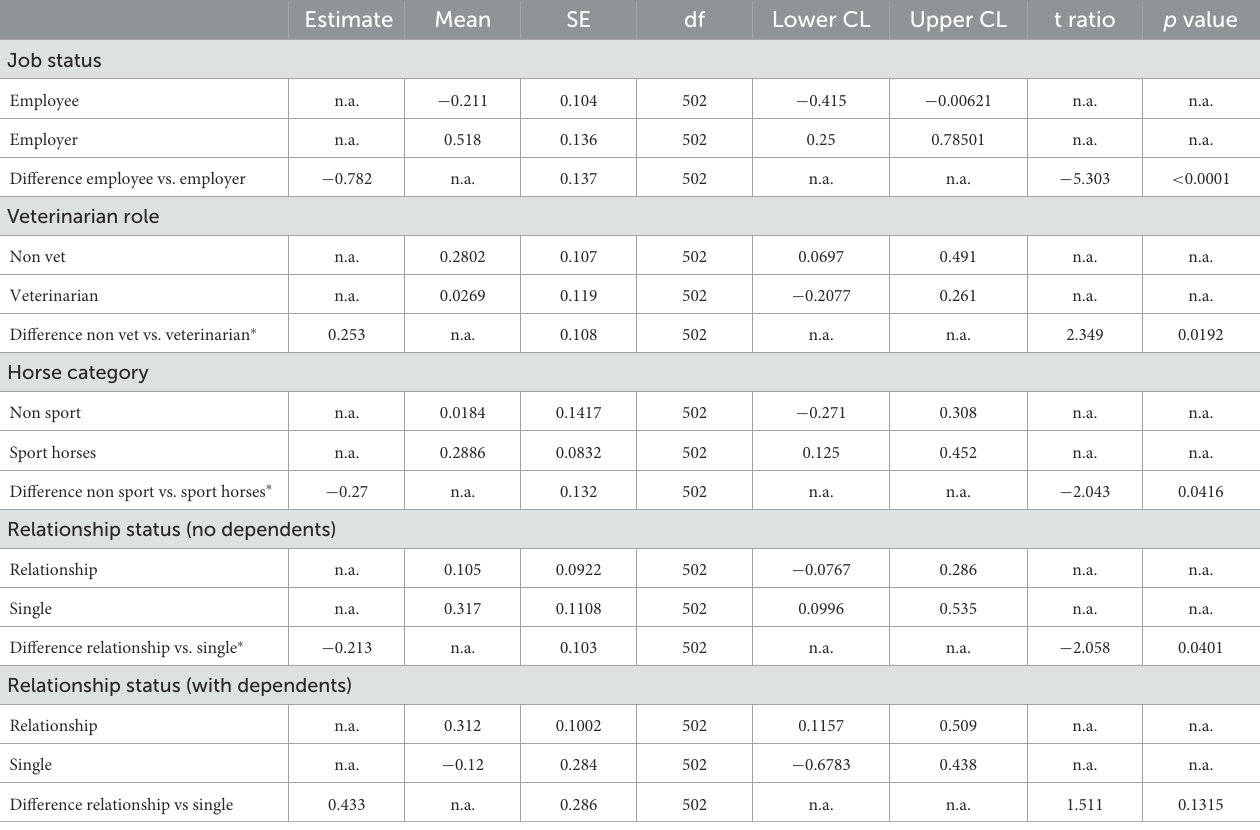
TABLE 2 Effect of factor “pride and purpose” on overall work satisfaction for job status, veterinarian role, horse category and relationship status (with/without